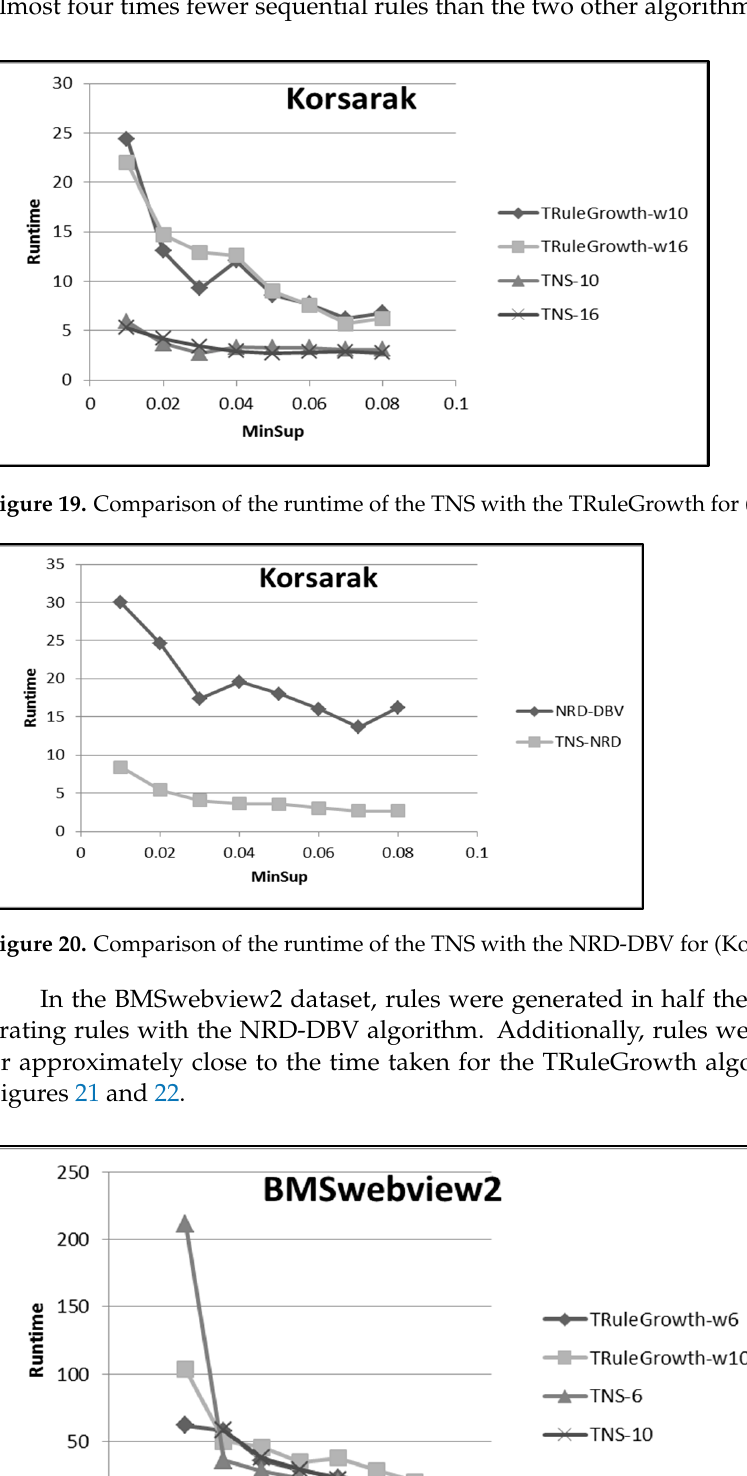
Figure 21. Comparison of the runtime of the TNS with the TRuleGrowth for (BMS webview2) da- taset.